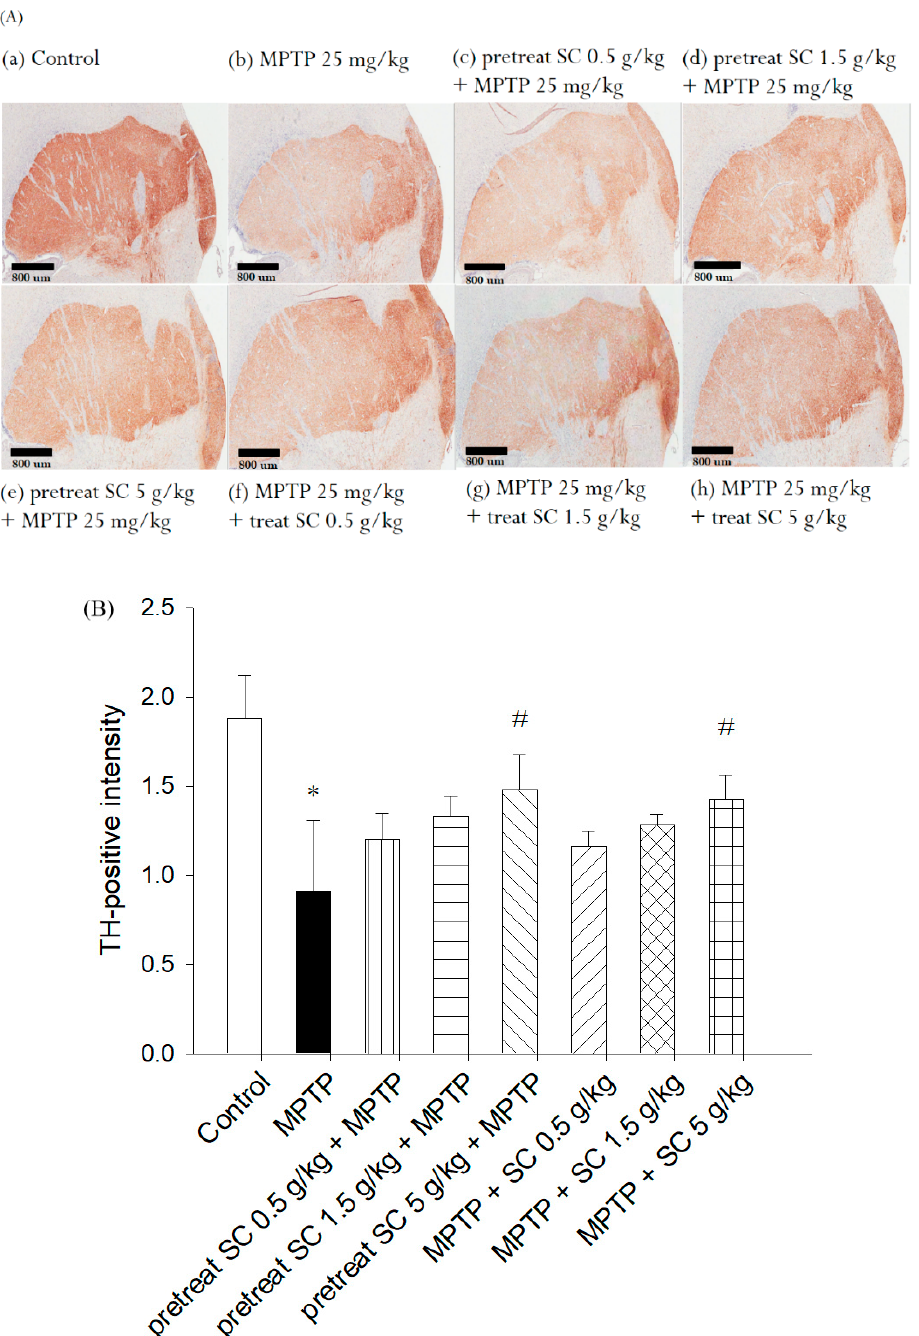
Figure 7. The e ff ects of S. chinensis treatment (0.5, 1.5 and 5 g / kg, p.o.) on tyrosine hydroxylase (TH) in the striatum of control and experimental mice. ( A ) Immunohistochemical staining of TH (magnification, × 80) in the (a) control group; (b) MPTP group; (c) pretreatment S. chinensis (0.5 g / kg, p.o.) + MPTP group; (d) pretreatment S. chinensis (1.5 g / kg, p.o.) + MPTP group; (e) pretreatment S. chinensis (5 g / kg, p.o.) + MPTP group; (f) MPTP + S. chinensis (0.5 g / kg, p.o.) group; (g) MPTP + S. chinensis (1.5 g / kg, p.o.) group; and (h) MPTP + S. chinensis (5 g / kg, p.o.) group. ( B ) Quantitative results of TH staining by scoring the intensity of TH-positive cells in the striatum. The data are presented as the mean ± S.D. ( n = 3). * p < 0.001 compared with the control group as determined by T -tests; # p < 0.05 compared with the MPTP (25 mg / kg, i.p.) group as determined by T -tests. MPTP, 1-methyl-4-phenyl-1,2,3,6-tetrahydropyridine; SC, Schisandra chinensis extract; TH, tyrosine hydroxylase.